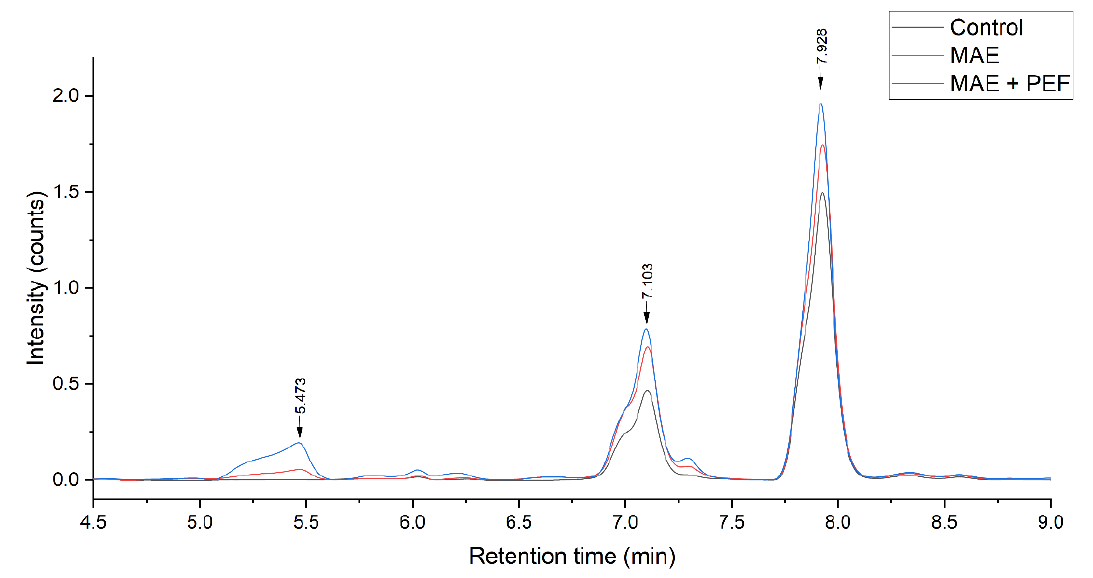
Figure 7. Effect of MAE + PEF treatment on the peaks of yellow coffee pulp. MAE: Microwave assisted extraction; PEF: Pulsed Electric Field pretreatment.